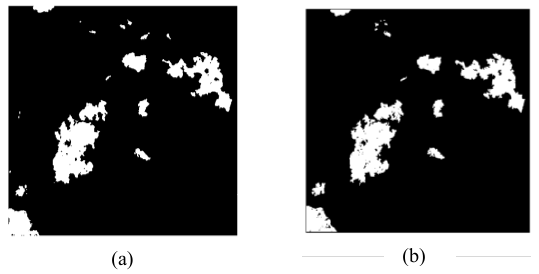
Figure 4. Change detection result of Mexico data set, (a) Proposed approach, (b) Ground